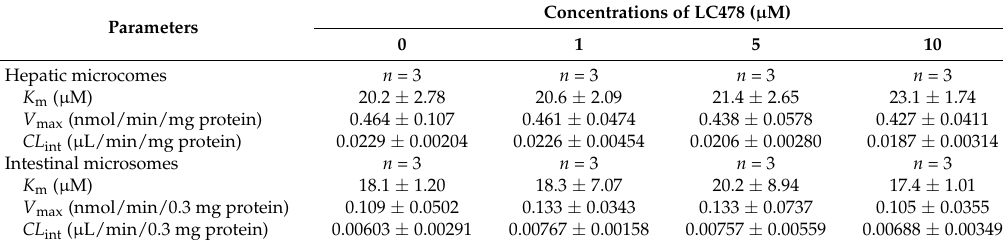
Figure 6. The graph for velocity versus docetaxel concentrations in hepatic ( A ) and intestinal ( B ) microsomes. Symbols represent LC478 concentrations: 0 ( ● ; n = 3), 1 ( ○ ; n = 3), 10 ( ▼ ; n = 3) and 50 ( ∆ ; n = 3) μ M LC478. Vertical bar represents SD. Table 4. K m , V max , and CL int for the disappearance of docetaxel with or without LC478 in hepatic and intestinal microsomes.